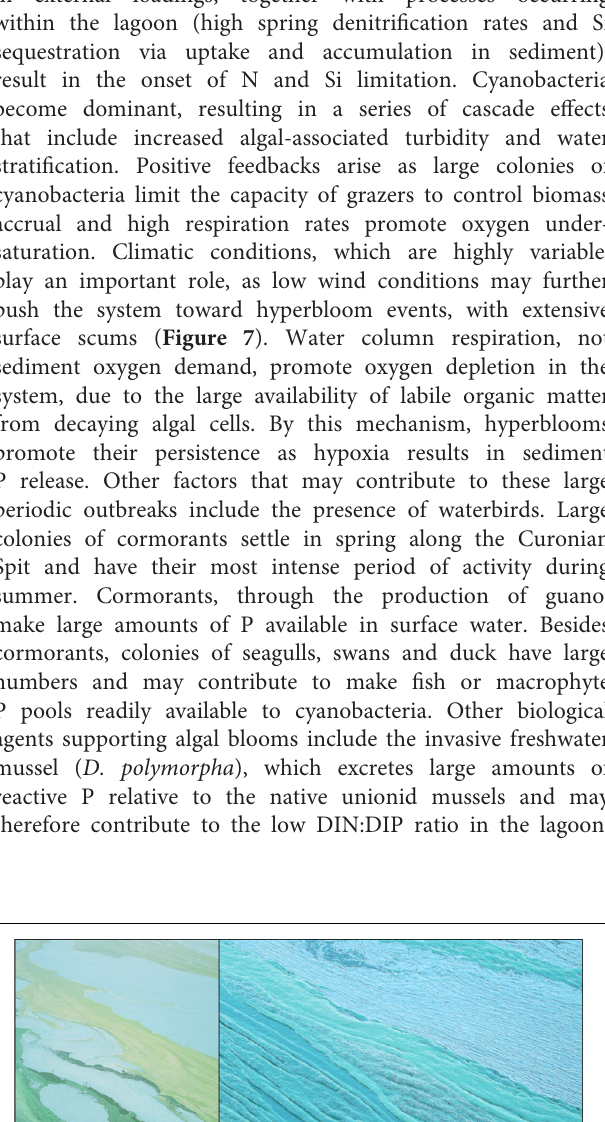
Frontiers in Marine Science |